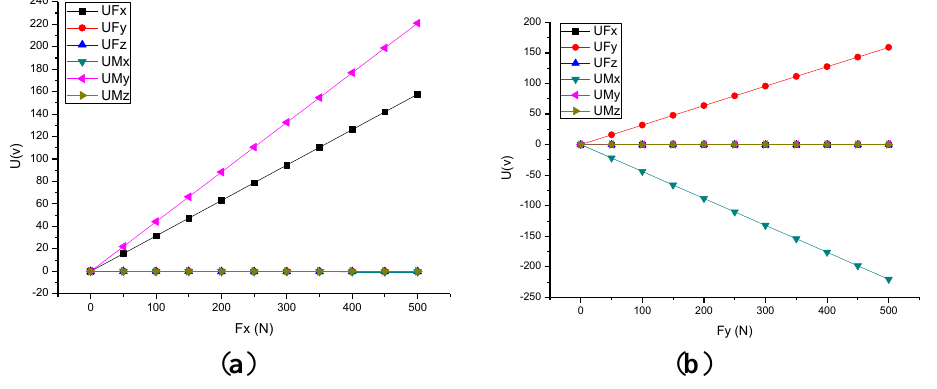
Figure 4. Selected input and output simulation characteristics of the sensor: ( a ) Force-potential curve in the F direction, ( b ) Force-potential curve in the F direction, ( c ) Strain cloud of X Y the sensor and quartz crystal chip groups under F , ( d ) Strain cloud of the sensor and X quartz crystal chip groups under F Y